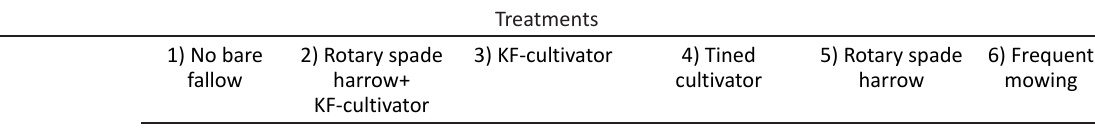
Table 2. Treatments and other farming operations in experiment 2 in 2012–2013